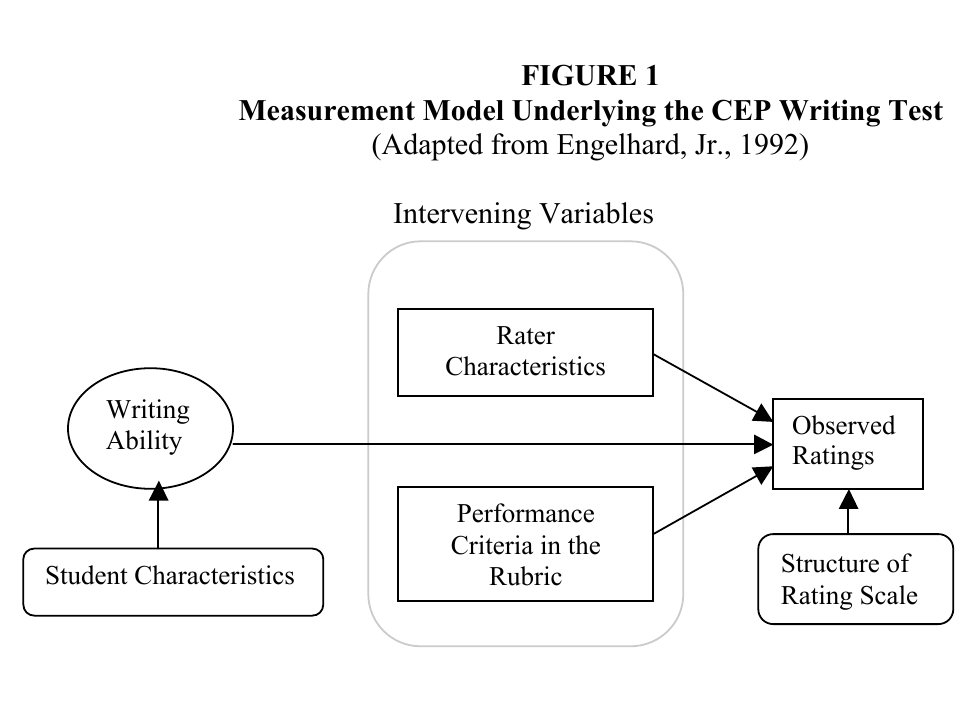
Observed Structure of Rating Scale